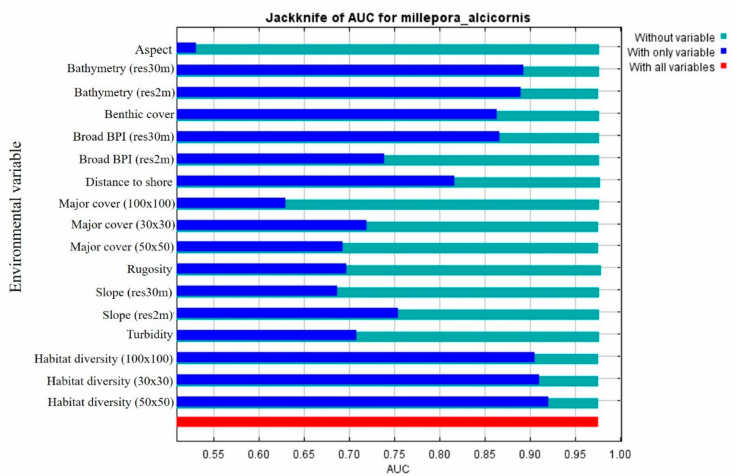
Figure 10. Jackknife test results exhibiting the influence of each variable on the final area under the receiver operating characteristic curve (AUC) value.